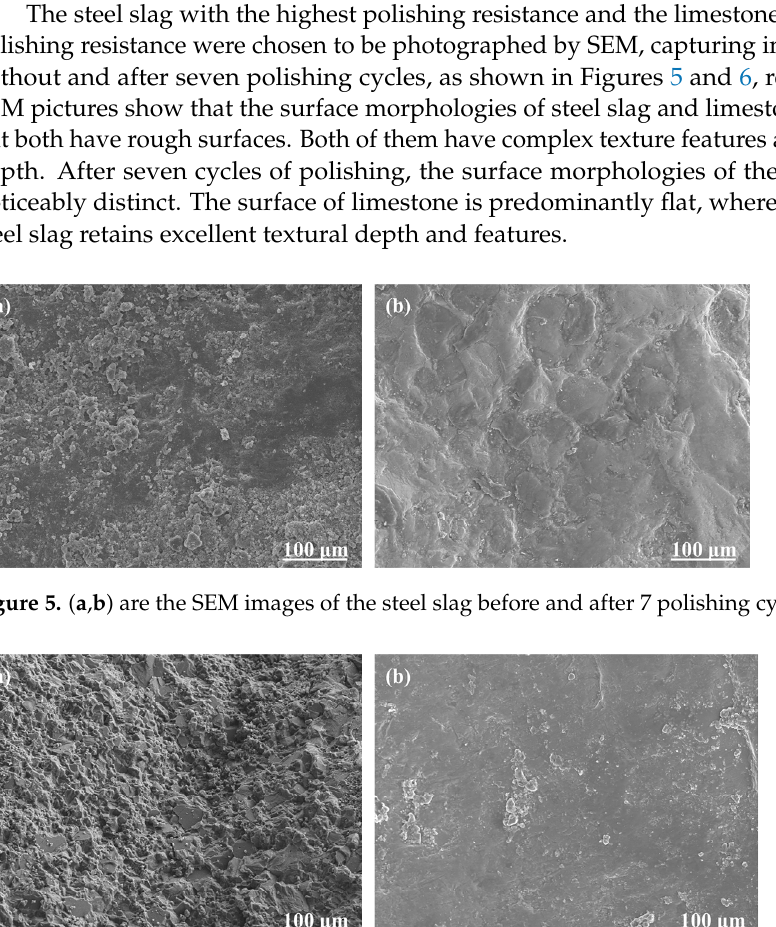
Figure 4. The change rate of PSV attenuation rate.